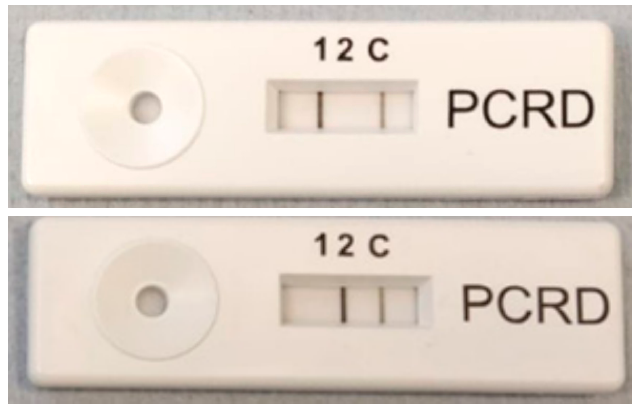
Figure 6. Results from solid-phase lysis followed by solid-phase RPA, analyzed on a lateral flow device supplied by Abingdon health. Line (1) indicates the amplified B. subtilis gene whilst line (2) indicates amplified E. coli gene. Line (c) is the control line. Top picture shows that B. subtilis has been detected whilst bottom picture shows that E. coli has been detected.